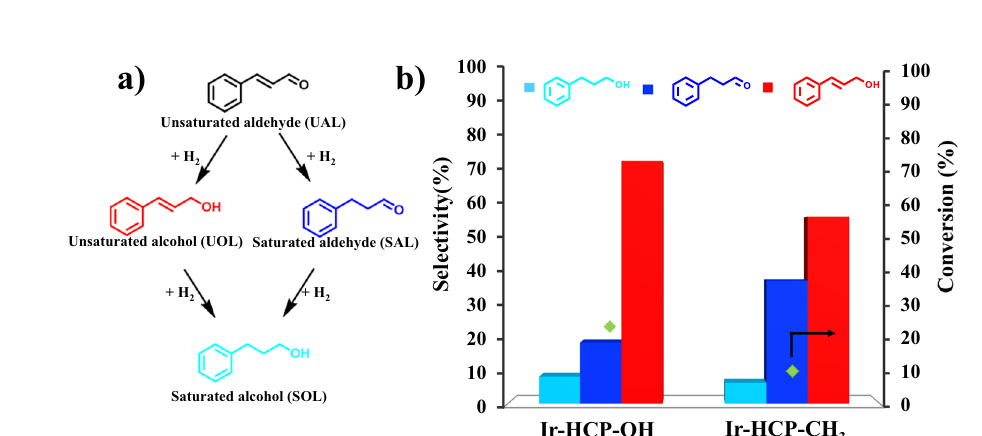
Fig.5|EffectofOHonreactionperformance.a Formationrateoffurfurylalcoholvs.OHdensity. b Solid-state 13 CCP/MASNMRoftheHCPwithvaryingOHdensity. c TOF vs. particle size. Error bars are SE obtained from repeated experiments.